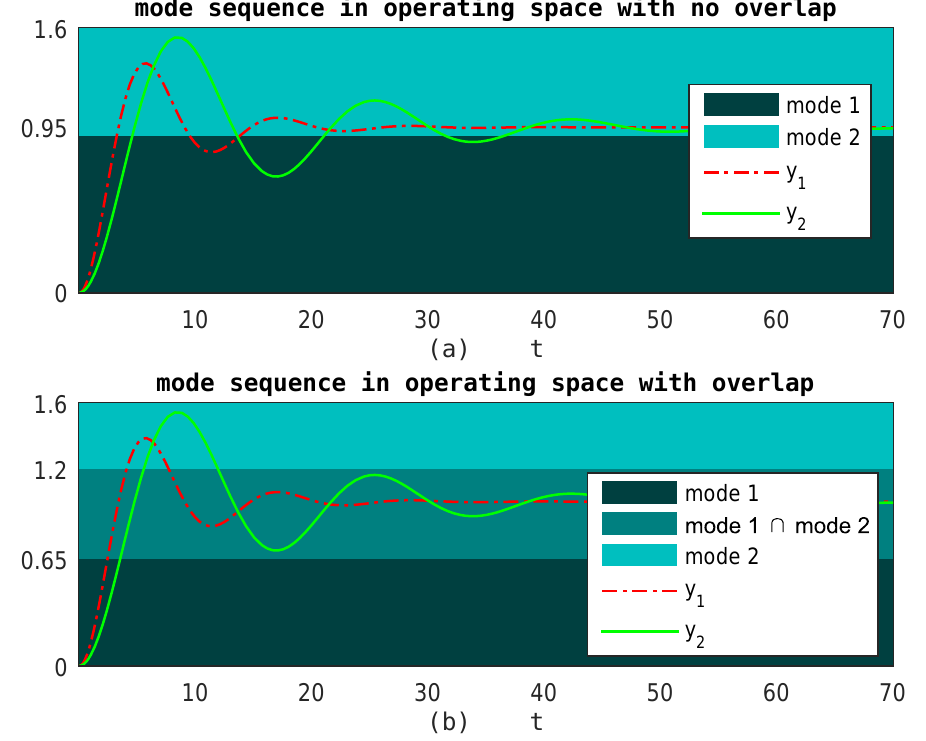
Figure 2. Trajectory of scheduling variable and mode switching sequence according to the cases without and with overlap,